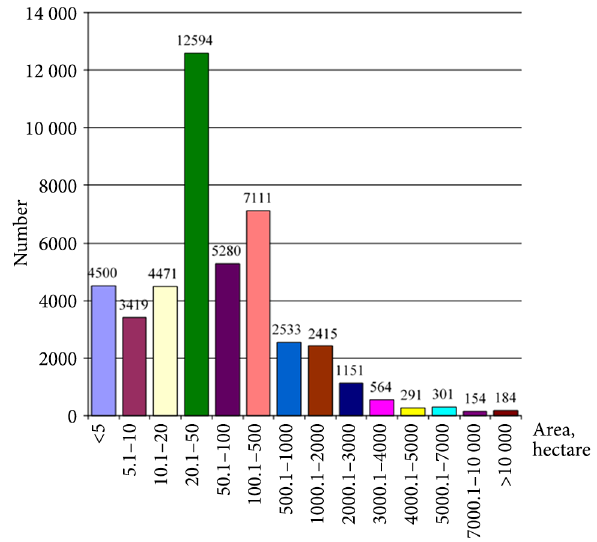
Figure 2. Distribution of agricultural enterprises by the average area of agricultural land